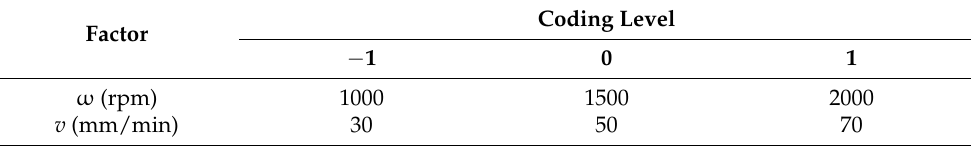
Table 3. Important factors and their levels.